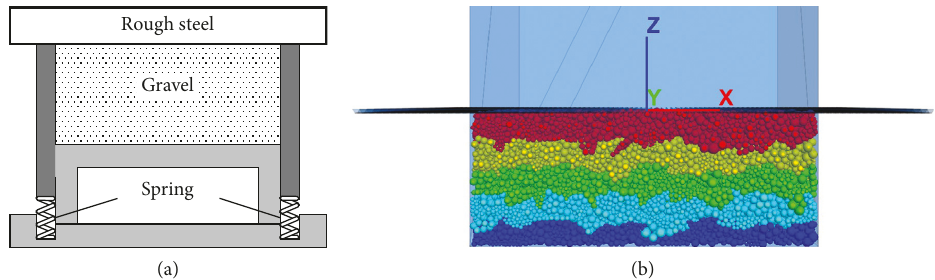
Figure 4: (a) Sketch of the interface text apparatus. (b) Schematic view of the five-layer compaction